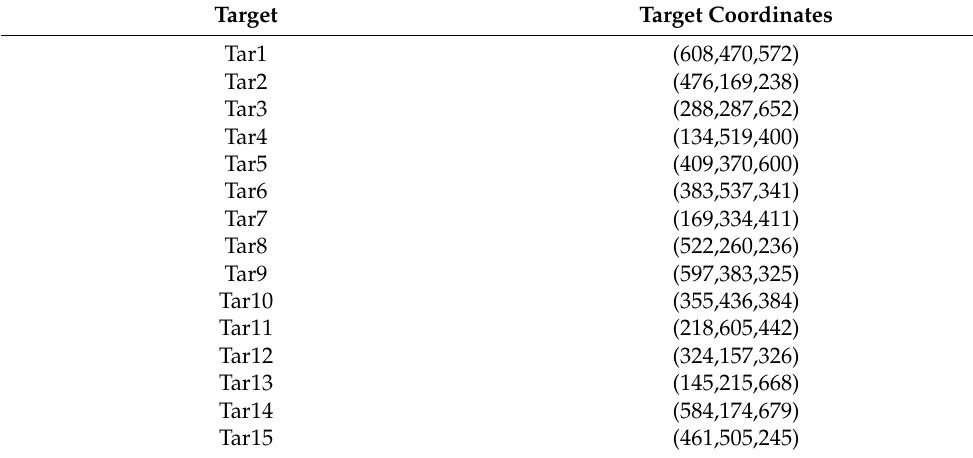
Table 2. Actual target